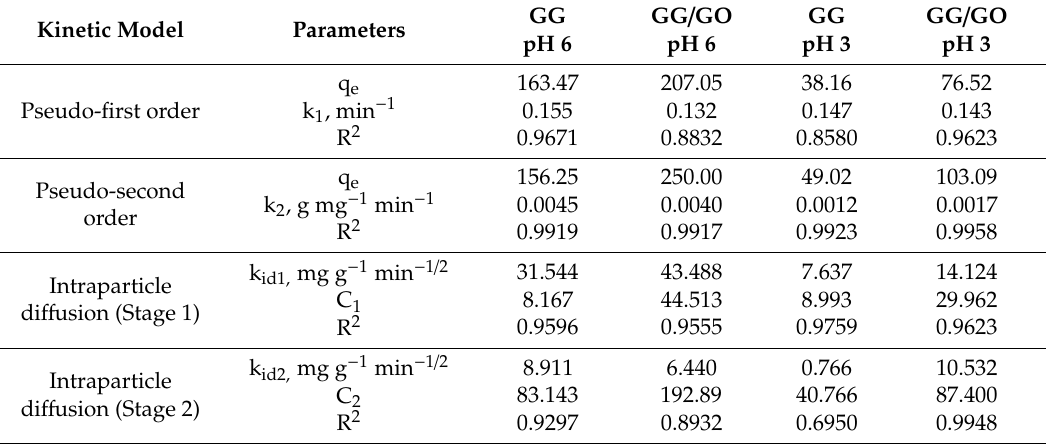
Table 4. Kinetic parameters and the correlation coefficients of Zn (II) sorption on GG and GG/GO.